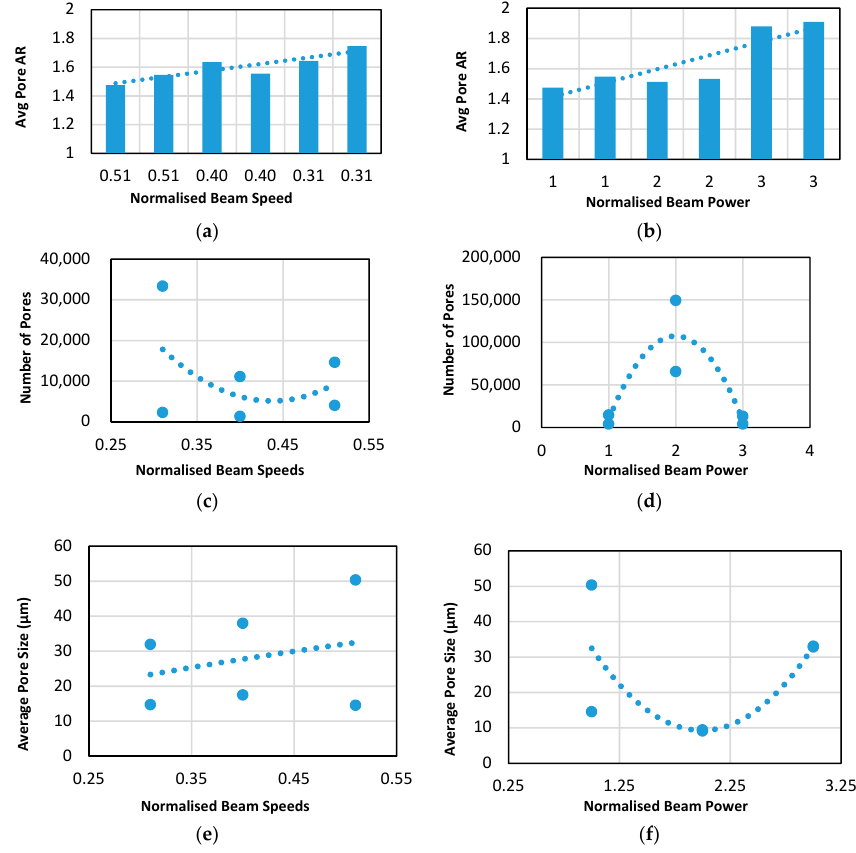
Figure 13. Melt track AR in relation to ( a ) beam speed and ( b ) beam power. Number of pores in relation to ( c ) beam speed and ( d ) beam power and average pore size in relation to ( e ) beam speed and ( f ) beam power.